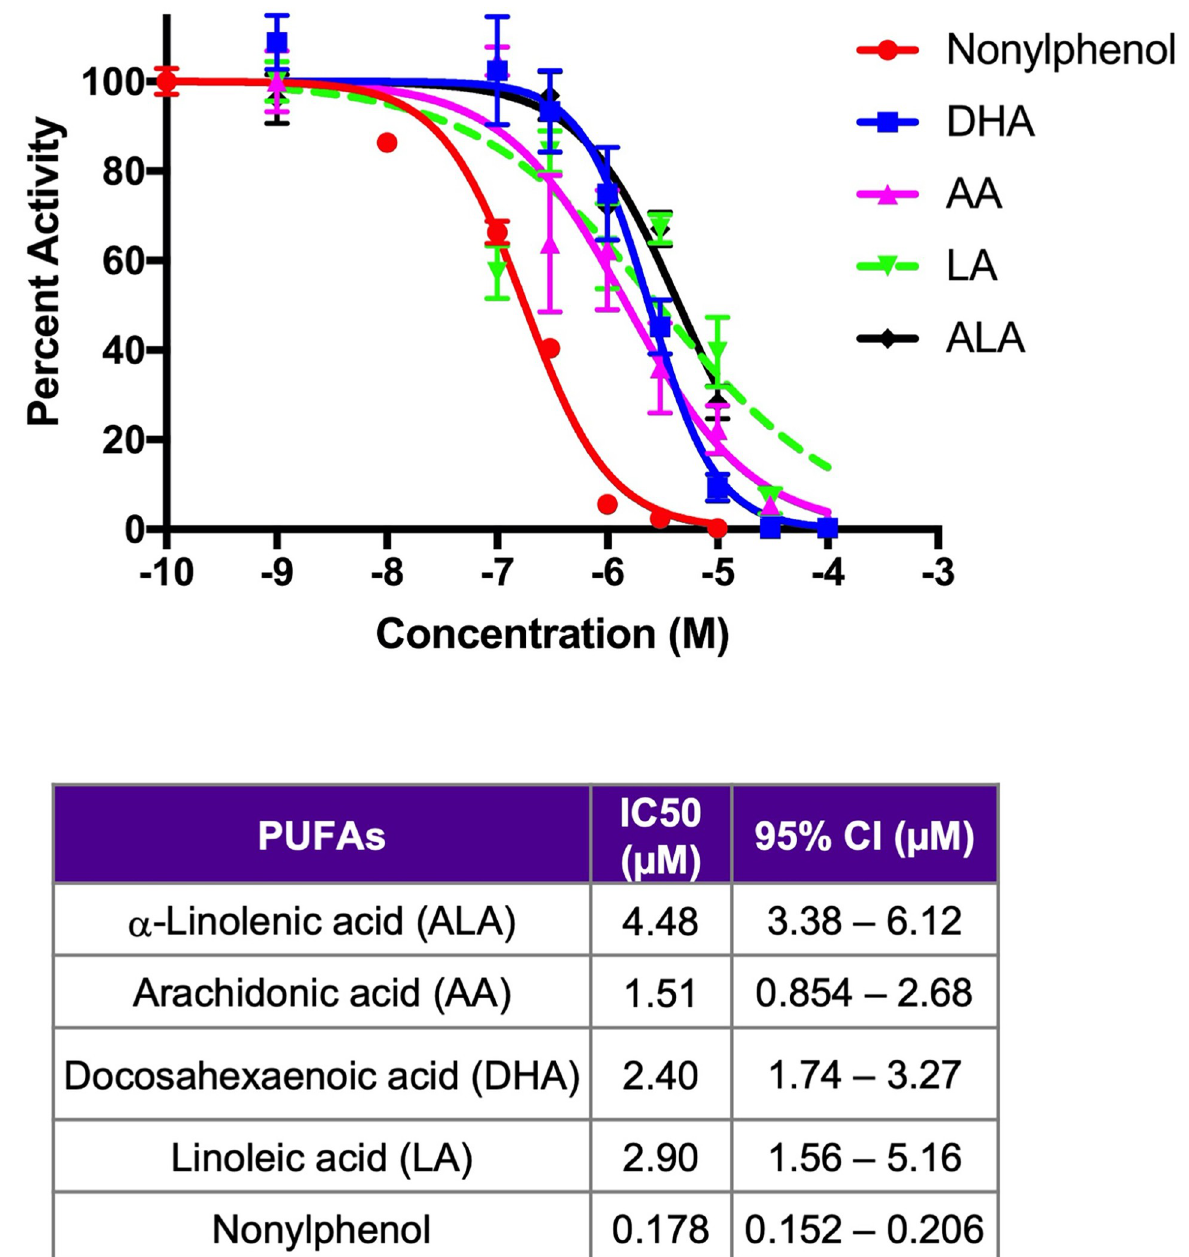
Fig 1. Fatty acid inhibitors of CYP2B6. Concentration-response curves of CYP2B6 containing baculosomes treated with polyunsaturated fatty acids (PUFAs) or nonylphenol (positive control). Data are generated as described in the Materials and Methods using GraphPad Prism 7.0 and presented as mean ± SEM in the graph with IC50s and 95% Confidence Intervals